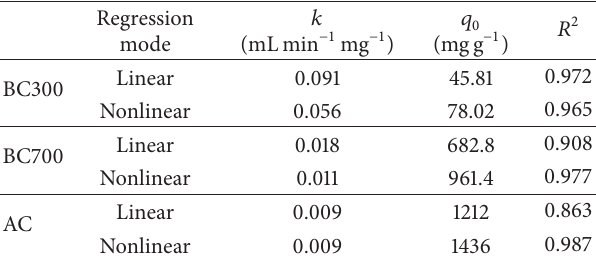
Table 3: Thomas model parameters for trichloroethylene (TCE) sorption onto biochars derived from soybean stover pyrolyzed